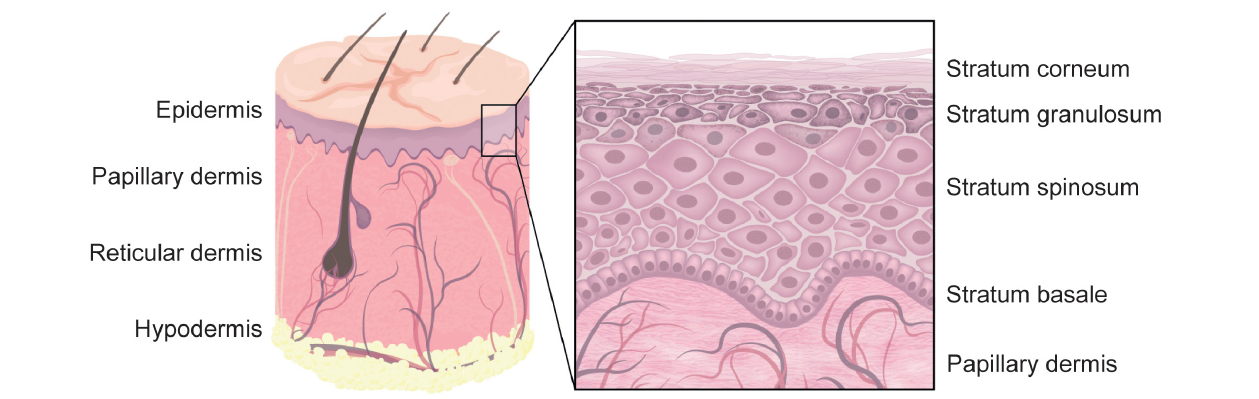
FIGURE 1 | Human skin. The outermost layer of human skin is built by stratified epidermis. The bottom layer is called stratum basale and contains proliferating basal keratinocytes that are anchored to the basement membrane. While differentiating, they migrate from the stratum basale, through the stratum spinosum, stratum granulosum, and the stratum lucidum (not shown) to the stratum corneum. The vascularized dermis can further be separated into the upper papillary and the lower reticular dermis. Skin appendages, such as hair follicles, are embedded in the dermis and reach through the epidermis, whereas other appendages reside mostly in the dermis. The innermost skin layer is called hypodermis and is built by fat storing adipocytes. Note that not all skin appendages, and skin cells are